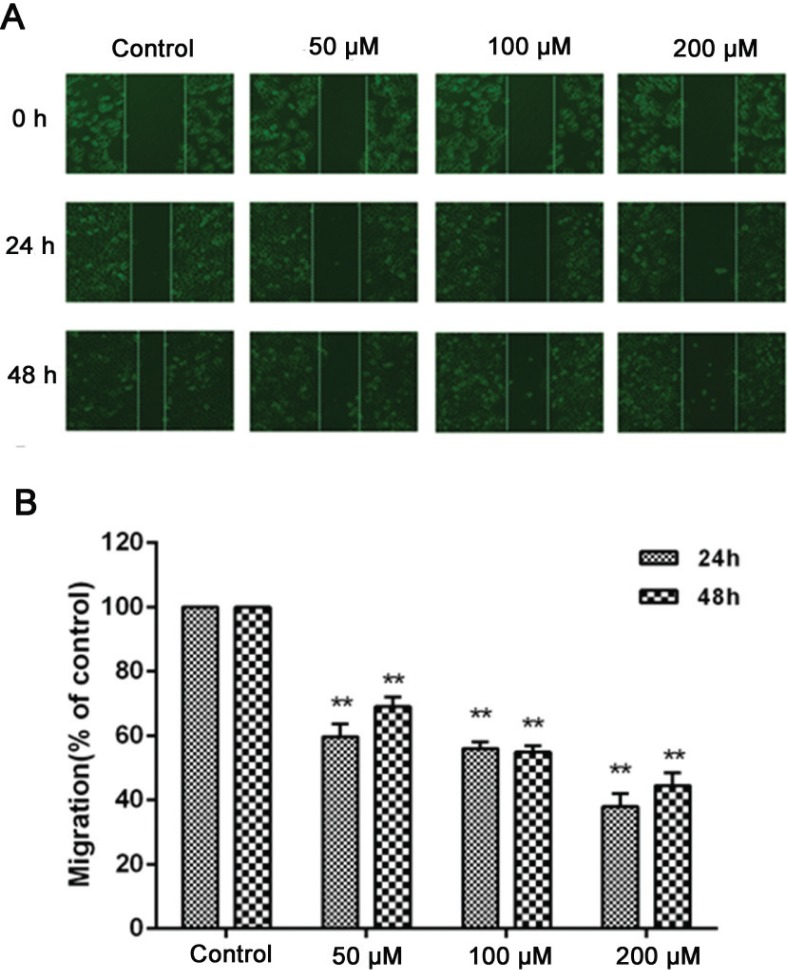
Effect of nobiletin on migration of MCF-7 cells. Cell migration was observed with a microscope (10×) at 24 and 48 h and the relative migration was calculated. (A) MCF-7 cells were seeded in 12-well plates, and the cell layer was scratched with a 10 μl sterile tip. (B) Cell migration was observed with a microscope (magnification, ×10) at 24 and 48 h. Data represented as mean ± SD of three independent experiments. **p < 0.01 compared with their respective controlcells.